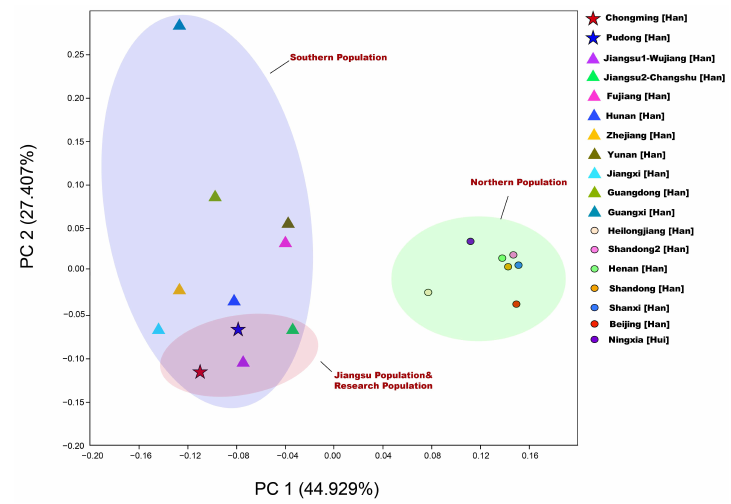
Figure 6. Principal component analysis based on the frequencies of haplogroups.